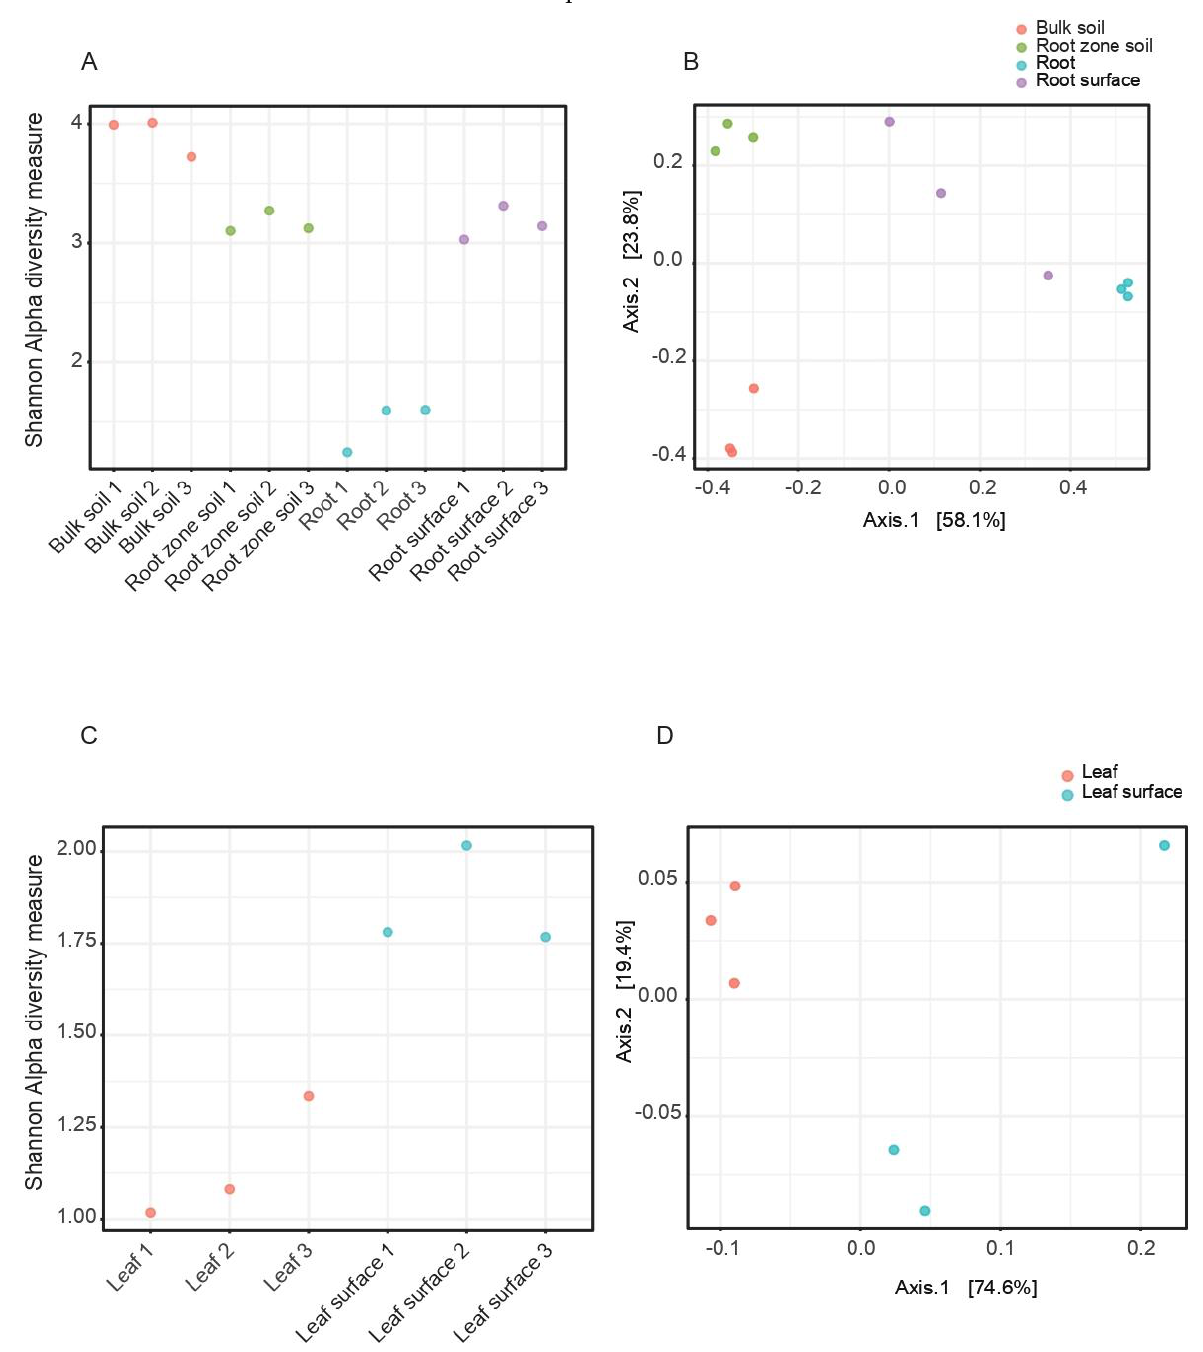
zone and two of the rhizosphere samples from the third rhizosphere sample, and the root tissue and control soil samples.